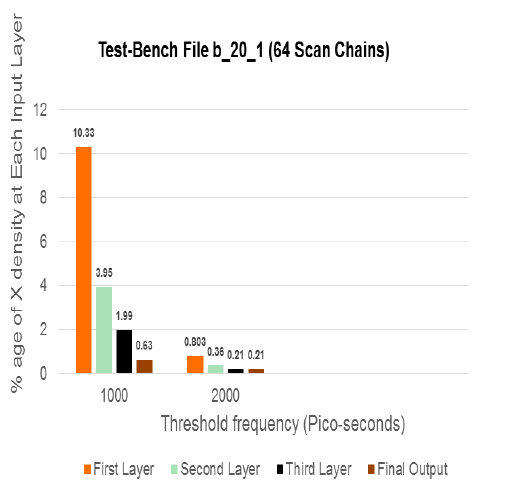
FIG. 11: TEST BENCH FILE B20_1(64 SCAN CHAINS